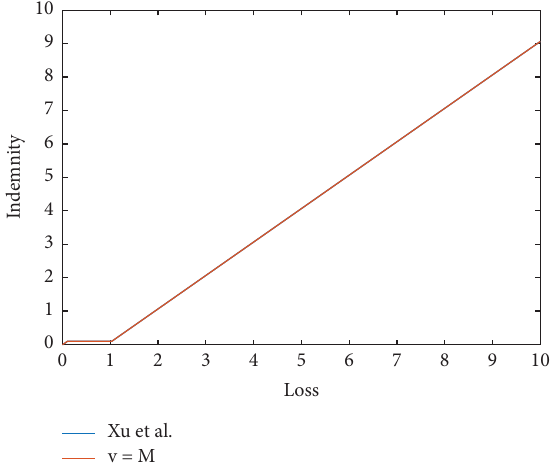
Figure 1: Optimal indemnities in our study and that of Xu et al. [3] with the same numerical setting.